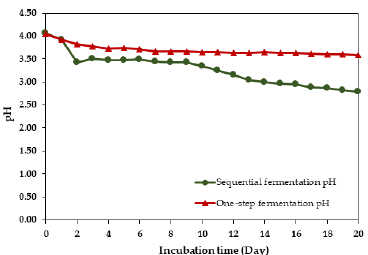
Figure 2. Change in pH of fruit vinegar in one-step and sequential fermentations.